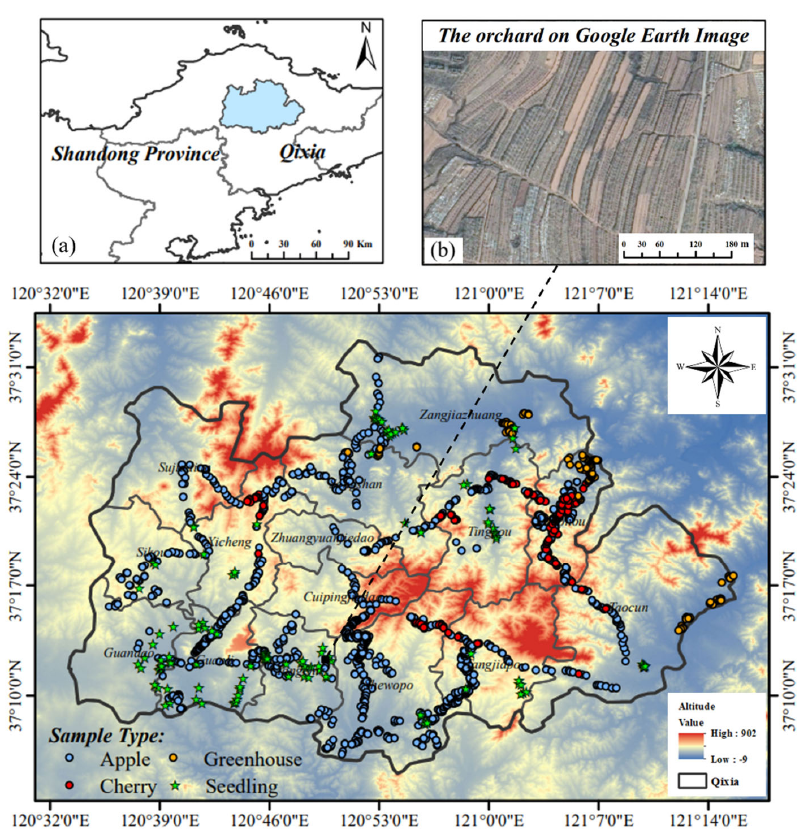
Figure 1. The location of the study area: the dot represents the location of the sampling point, and the background is DEM. ( a ) Shows the geographical location of the study area. ( b ) Shows the visual characteristics of the orchard on a Google Earth image.